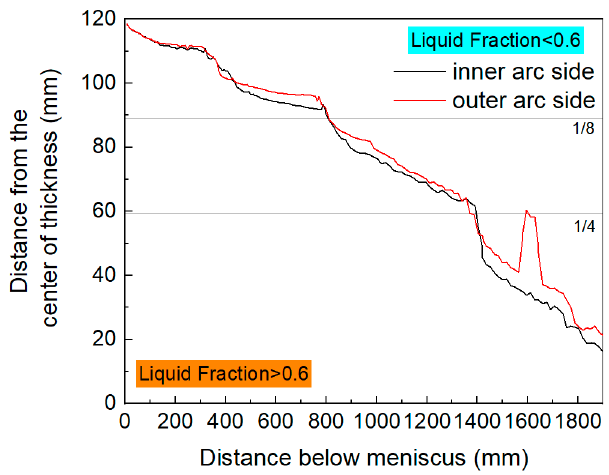
Figure 13. The distribution of the liquid fraction of 0.6 in the X = 450 plane of the mold.